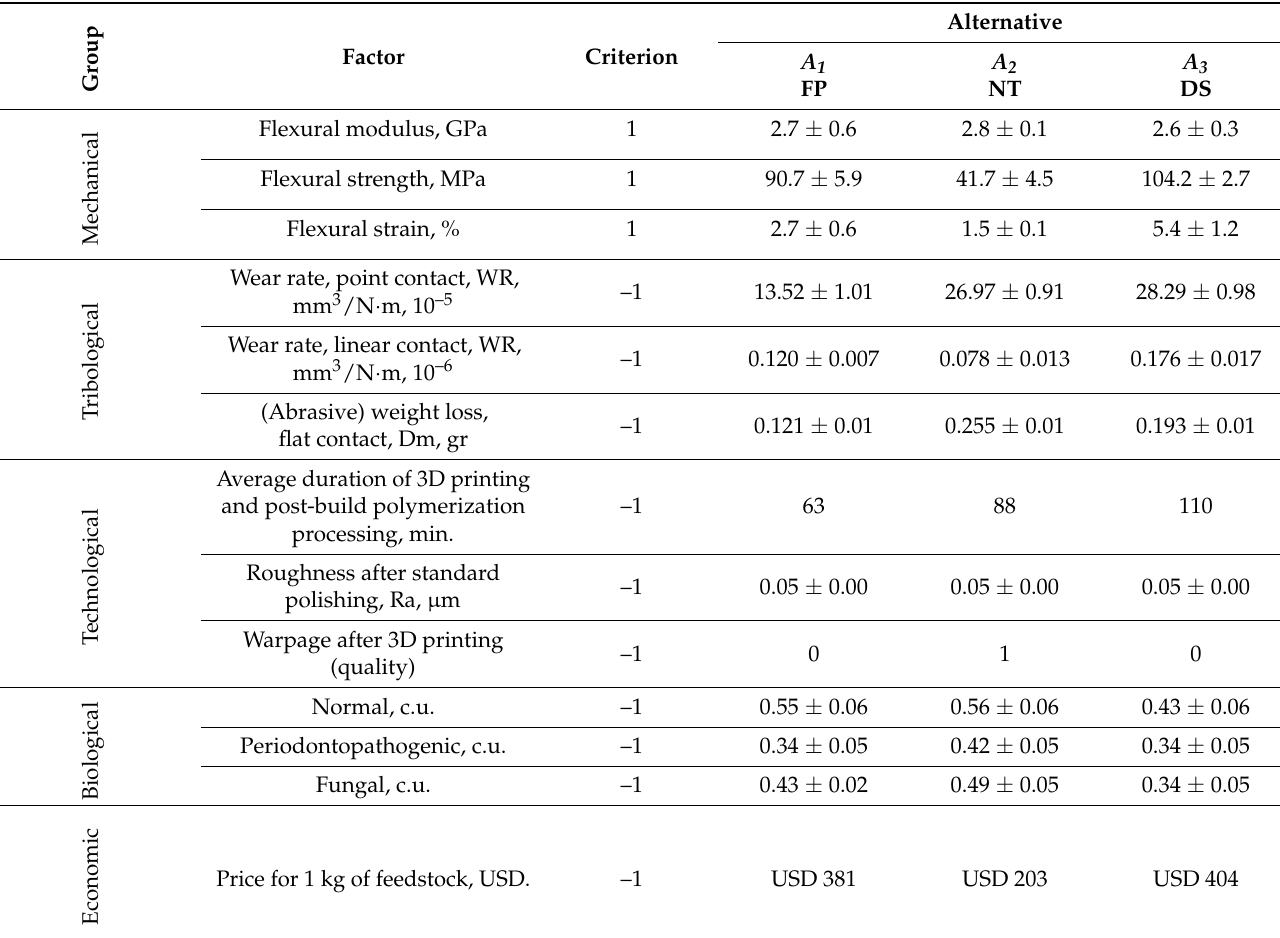
Table 9. The alternatives, their factors, and the criteria for the initial data